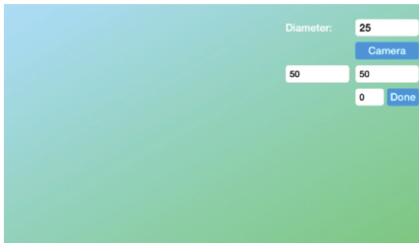
Figure 3: Interface of selecting a monitoring